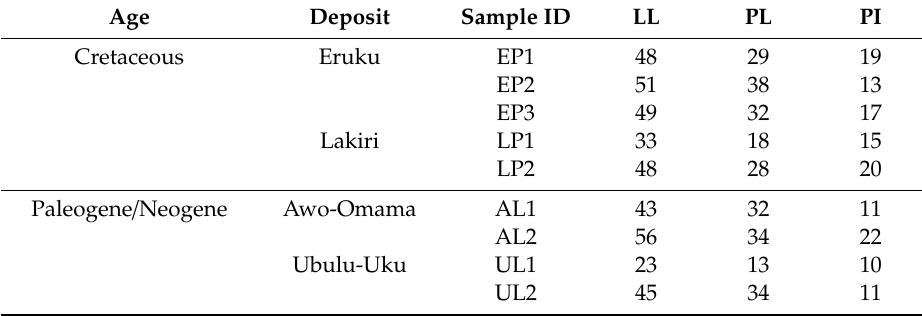
Table 3. Liquid limit (LL), plastic limit (PL), and plastic index (PI) (%) of the studied Cretaceous– Paleogene/Neogene kaolins.